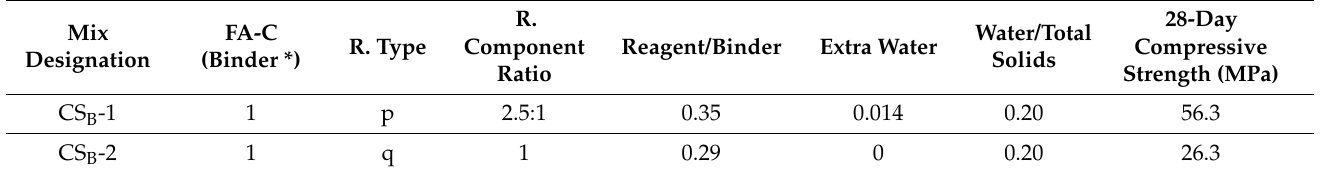
Table 4. Mix proportions of two-part binders (two mixes with FA-C).